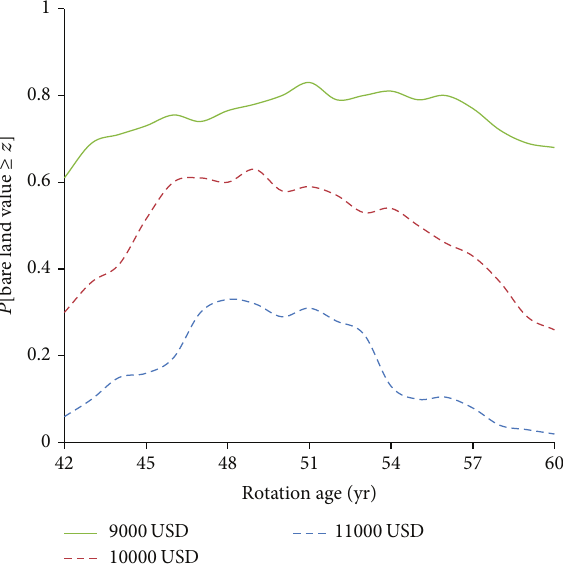
Figure 4: Probability that a computed bare land value (Dulaer 76) is greater than the specified bare land value target, 𝑧 , for different rotations. The three targets are 9000, 10000, and 11000 USD, with 0.02 probability of catastrophic insect outbreak. Interest rate is